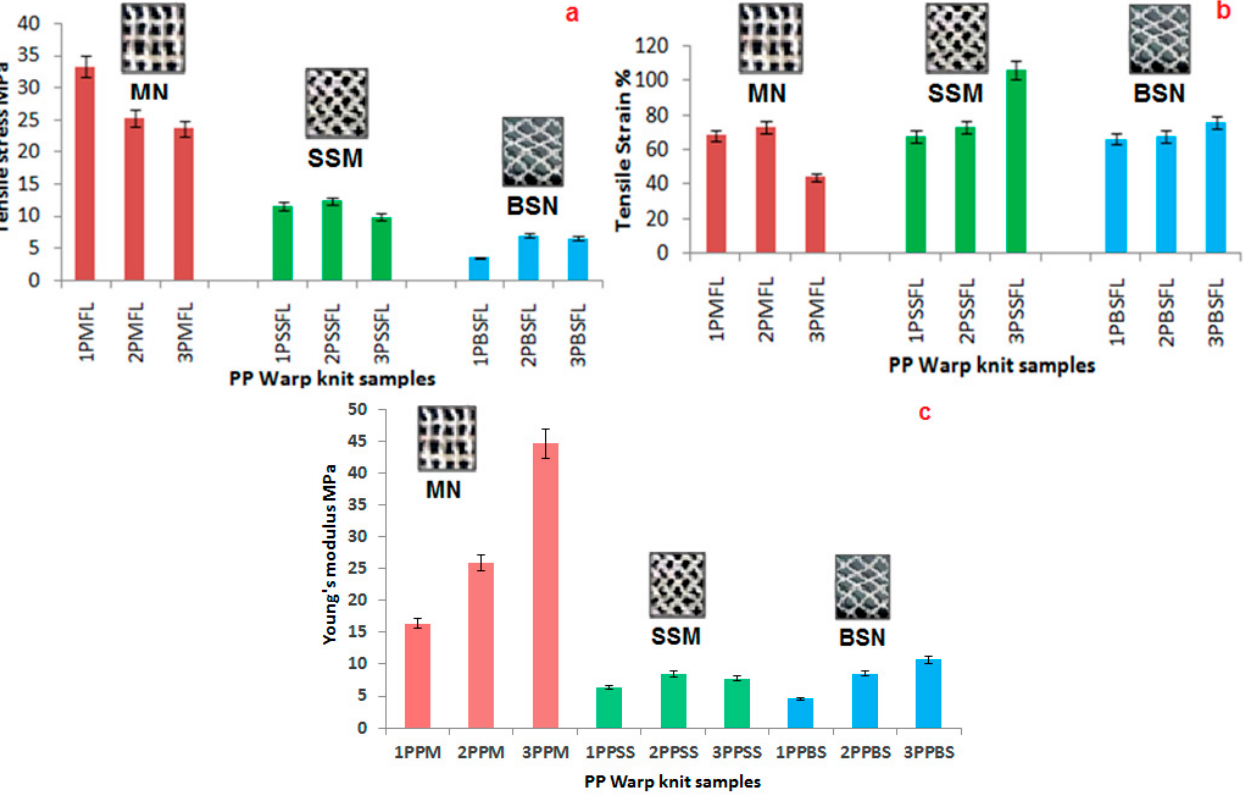
Figure 6. Tensile properties of Polypropylene warp knitted samples ( a ) tensile stress, ( b ) tensile strain, and ( c ) Young’s modulus.